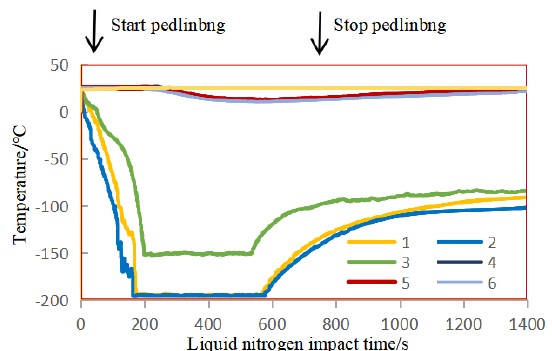
Figure 5. Locations of the thermocouple tips and temperature evolutions during the cryogenic thermal shock experiments (sample 1).